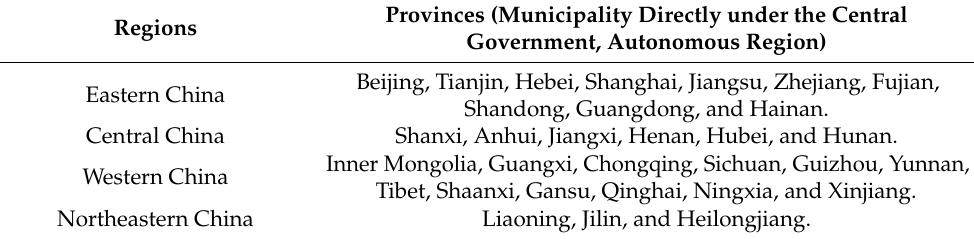
Table 3. The four regions in China.